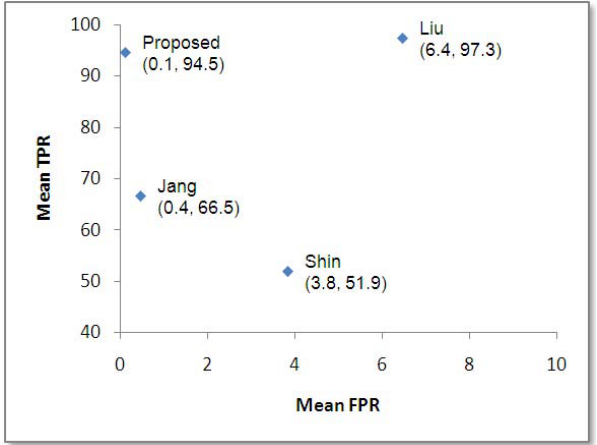
Figure 9. Receiver operating characteristics plot of binarization performance with mean TPR and mean FPR for various binarization